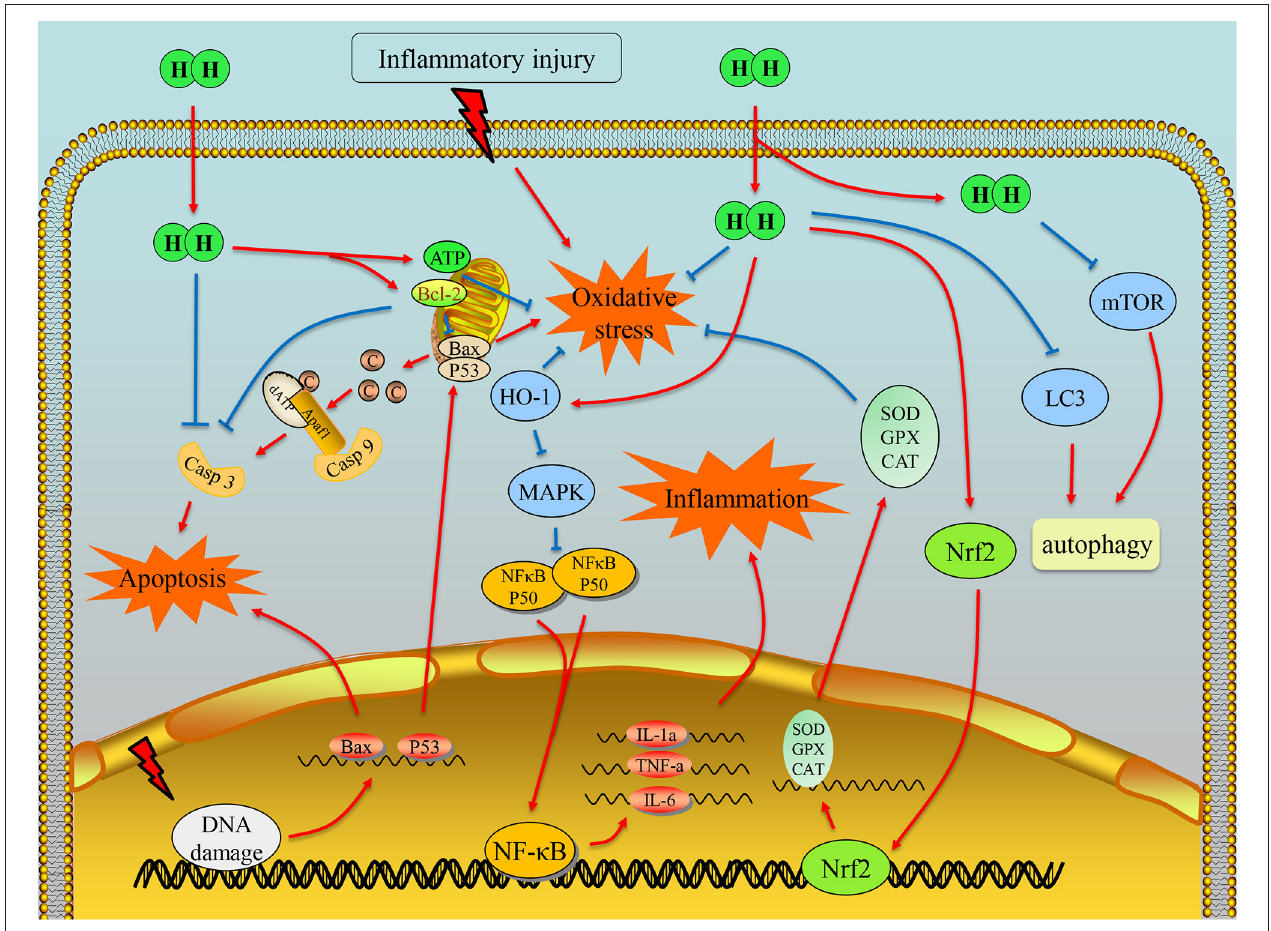
FIGURE 4 | Illustration of the main mechanism of hydrogen therapy in inflammatory diseases. First, hydrogen can scavenge hydroxyl radical due to its chemical property. It can also exert the antioxidation effects by regulating transcription of Nrf2 and energy balance of mitochondria. Moreover, hydrogen could downregulate the transcription of NF- κ B, so that the inflammation can be alleviated. With the effects on antioxidation, anti-inflammation, and antiapoptosis factor Bcl-2 or direct interaction with caspase-3, hydrogen can inhibit cell apoptosis.